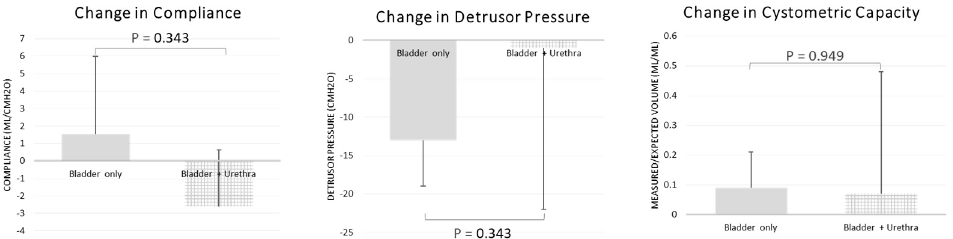
Figure 2. Change in bladder compliance, detrusor pressure, and cystometric capacity, comparing bladder BoNT-A group with bladder plus urethra BoNT-A group after BoNT-A injection. There was no signi fi cant improvement in compliance, detrusor pressure, or cystometric capacity between groups.